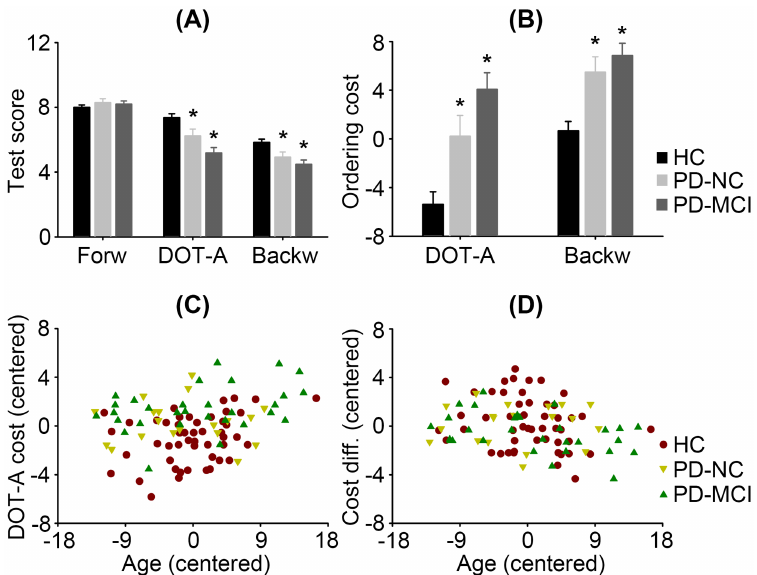
Fig 1. Test scores and ordering costs. (A) Mean test scores and standard errors of the adaptive digit ordering test (DOT-A), digit span forward (Forw) and backward tests (Backw) in mild PD patients with normal global cognition (PD-NC) or with mild cognitive impairment (PD-MCI) and in healthy controls (HC). The mean values were adjusted to 63.9 years of age and 12.8 years of education. Asterisks ( (cid:3) ) indicate significant differences between patients and controls ( p < 0.05). (B) Mean ordering costs and standard errors of the DOT-A and backward test in each group. The mean values were age- and education-adjusted. Asterisks indicate significant differences between patients and controls. (C) The DOT-A ordering cost increased in older adults across groups. The values were mean-corrected. (D) Difference between the DOT-A ordering cost and backward ordering cost decreased in older adults across groups. The values were mean-corrected.